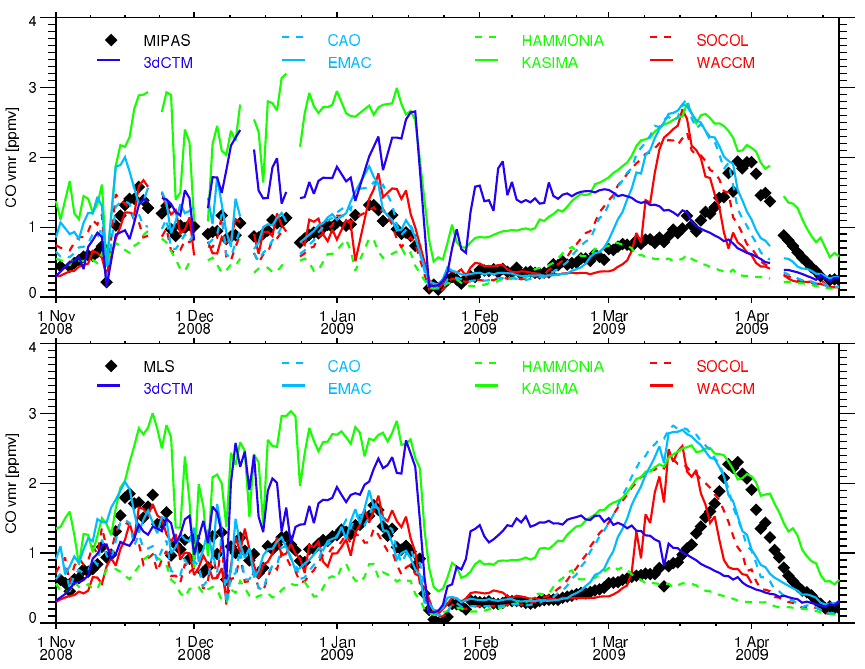
Figure 11. MIPAS-NOM (top) and MLS/Aura (bottom) temporal evolutions of CO VMR in comparison with the model results within 70–90 ◦ N at